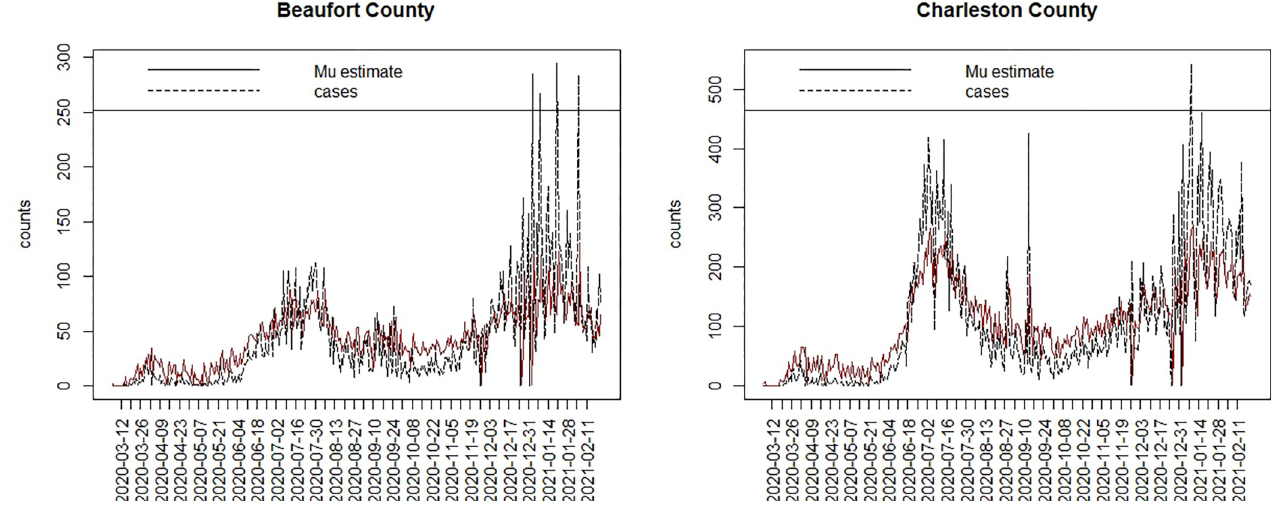
Fig 3. Case count and posterior mean risk estimate for Beaufort (L) and Charleston (R) county.